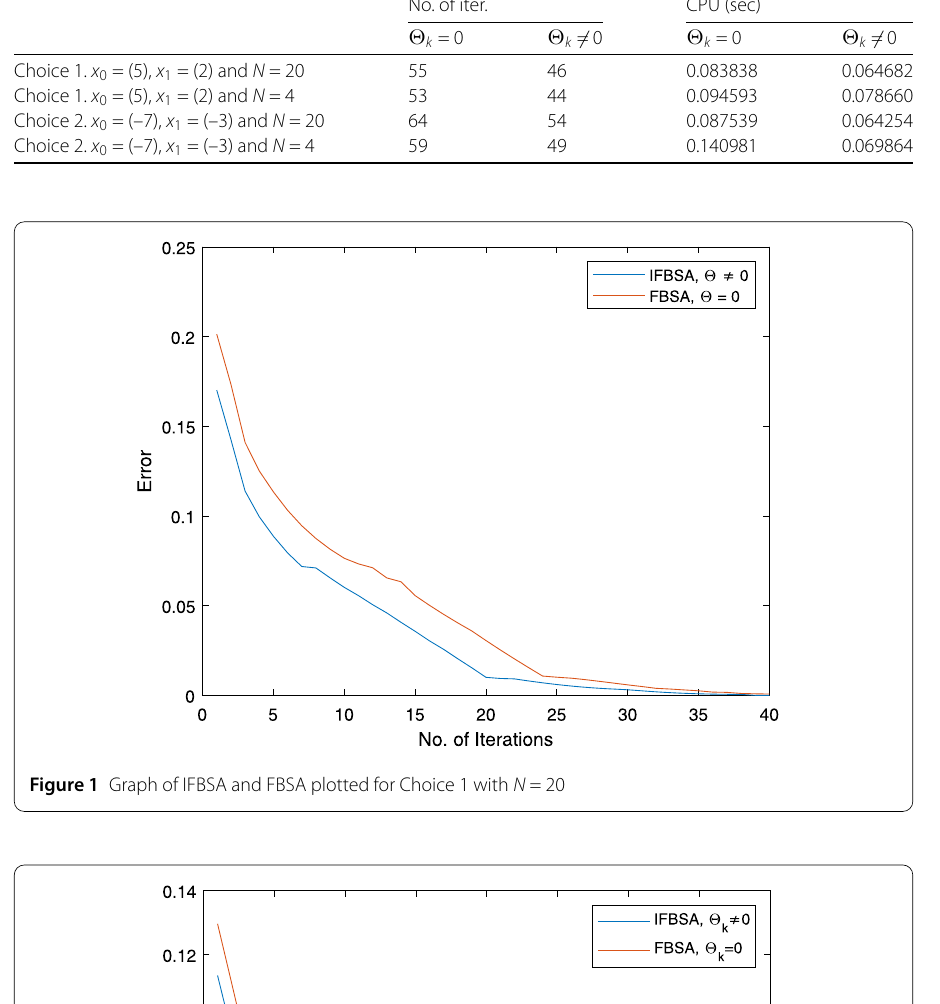
Table 1 Numerical results for Example 4.1 Choice 1. x 0 = (5), x 1 = (2) and N = 20